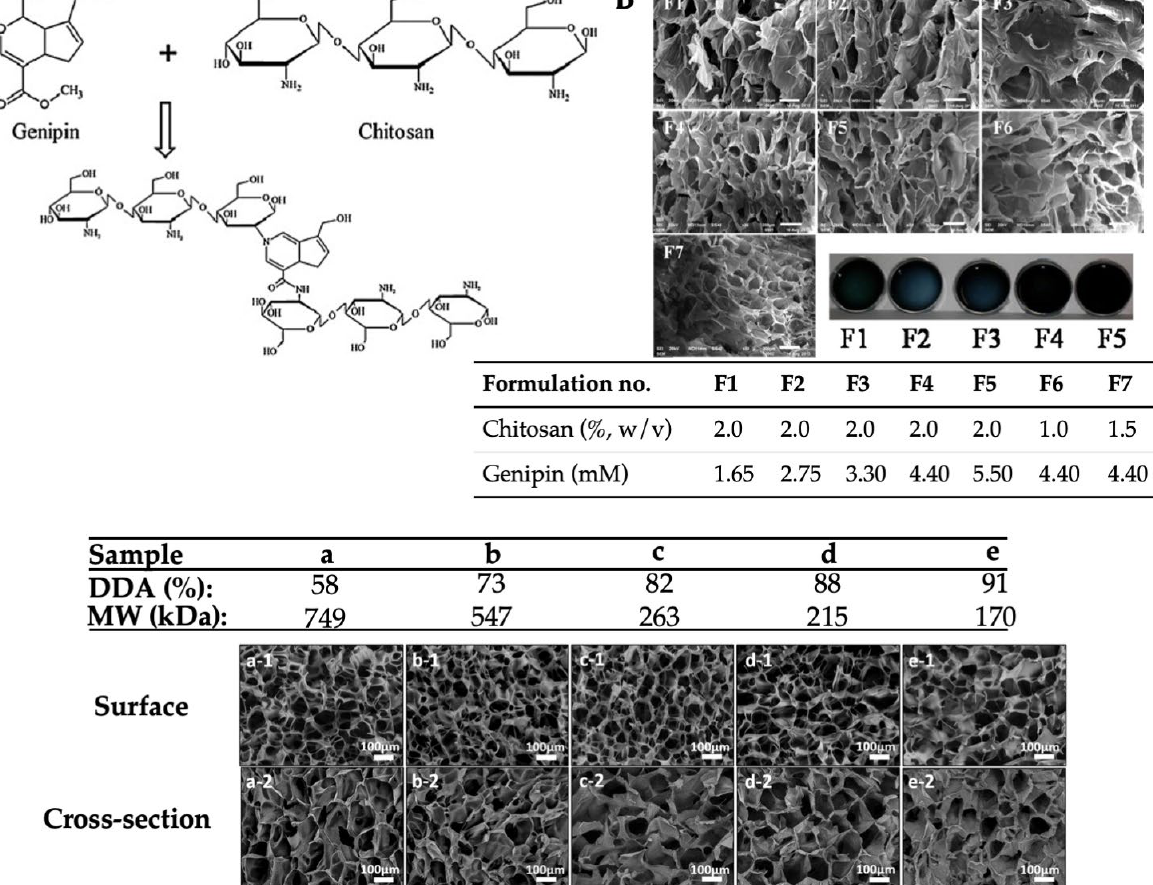
Figure 3. Mechanism of crosslinking between chitosan and genipin molecules ( A ), SEM images and photographs of genipin crosslinked chitosan hydrogels prepared by different formulations ( B ) (the scale bars represent 200 μm). The inserted table shows formulation codes ( F1 – F7 ) by using different concentrations of chitosan (85–95% DDA and MW of 300-450 kDa) and genipin [reprinted with permission from ref. [119] Copyright © 2014, Elsevier]. At 2% w/v chitosan and 0.02% w/v genipin ( C ), the different DDA and MW of chitosan are used to fabricate hydrogels, samples a–e (inserted table). SEM images show surface (a-1 to e-1) and cross-sectional (a-2 to e-2) morphologies of genipin crosslinked chitosan hydrogels (the scale bars represent 100 µ m) [reprinted with permission from ref. [120] Copyright © 2021,